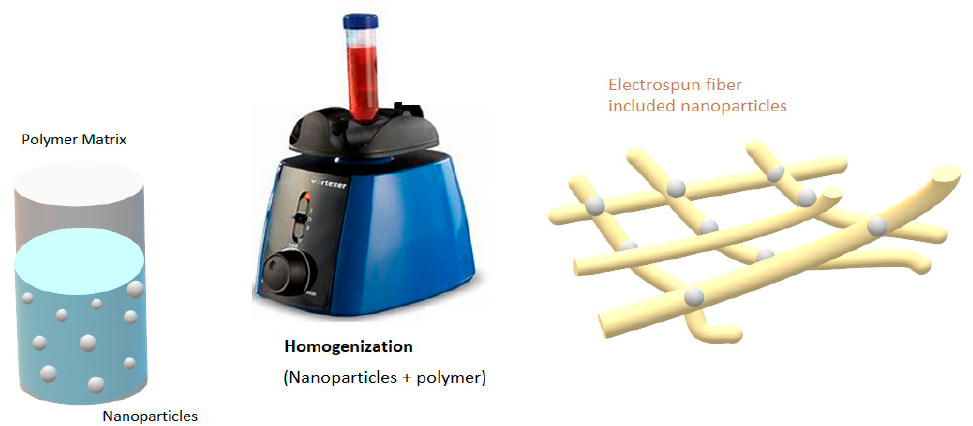
Figure 1. Nanoparticles included into the polymer matrix for the obtained electrospun.